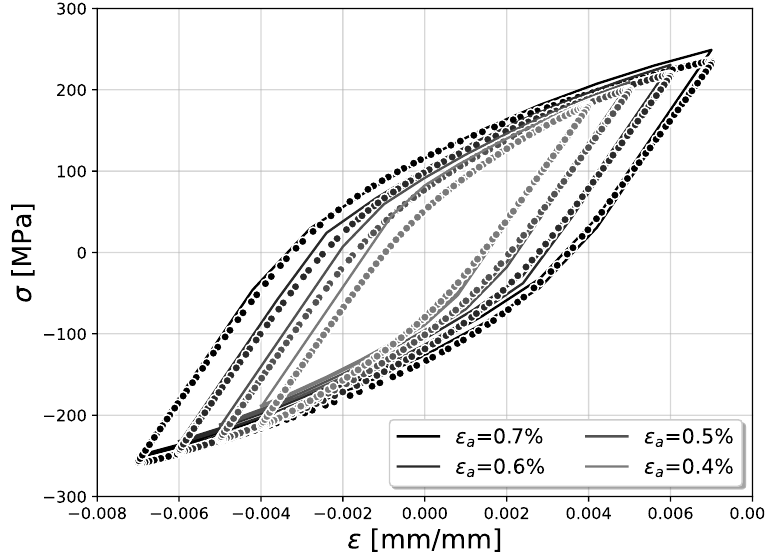
Figure 6. Comparison between the experimental and the numerical hysteresis cycles obtained from a FE